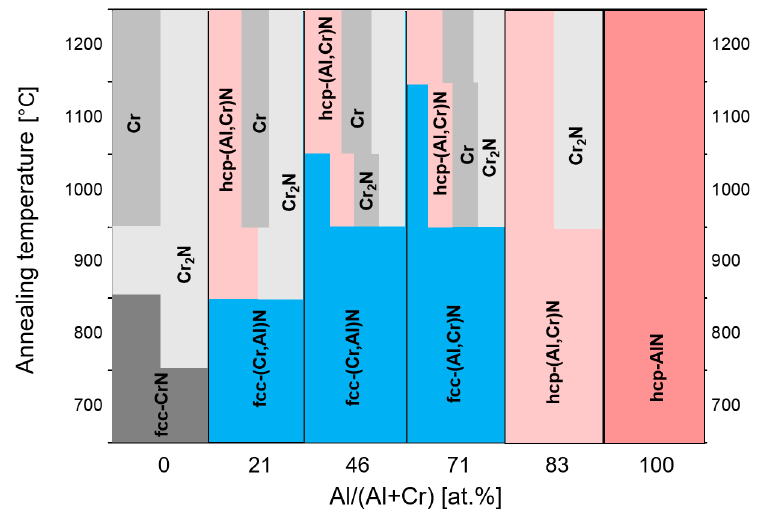
Figure 10. Schematic diagram of phase stability for (CrAl)N and (AlCr)N as determined by XRD spectra after annealing at different temperatures, redrawn after [61], original © Elsevier.